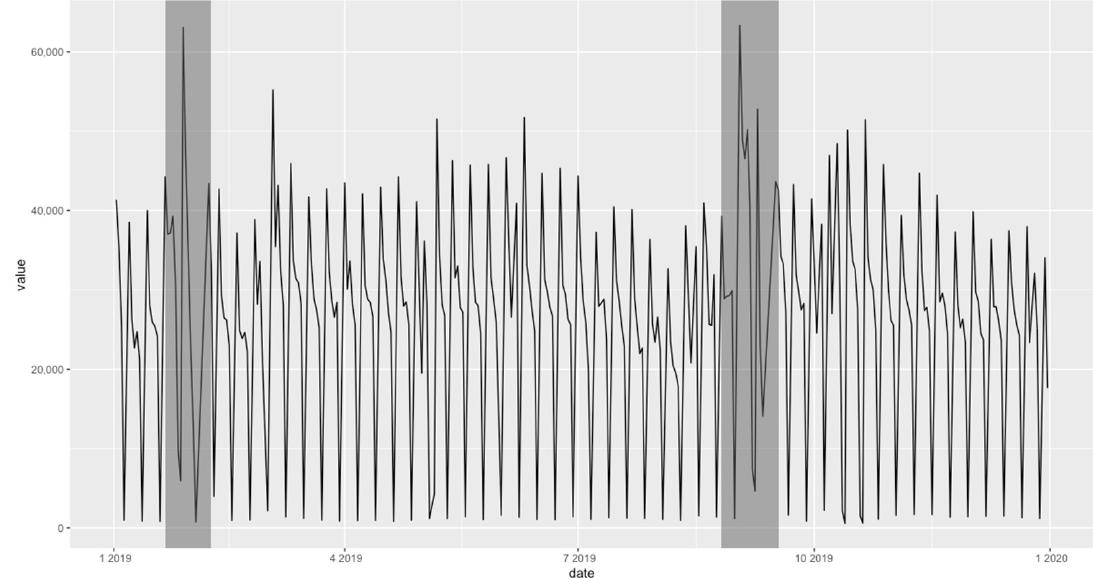
Figure 5. Example of postal parcel data of a mail center.